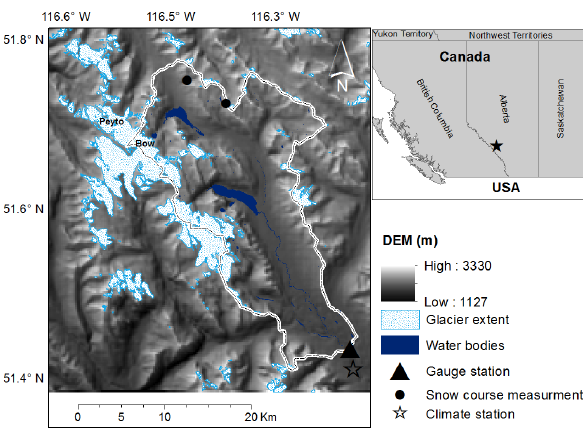
Fig. 2. Location of the upper Bow River basin, stream gauging sta- tion above Lake Louise, snow course and Lake Louise climate sta- tion locations. Glacier cover is based on the Landsat image acquired on 26 August